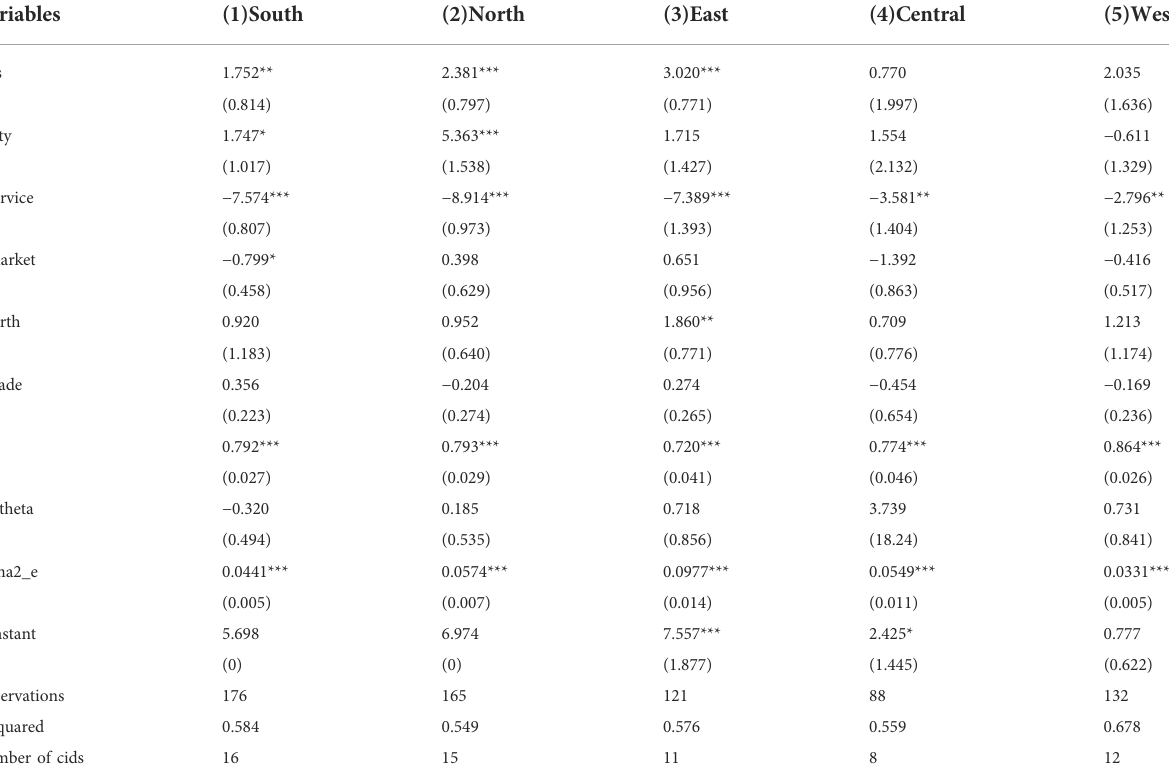
TABLE 4 Spatial econometric regression results in different regions.